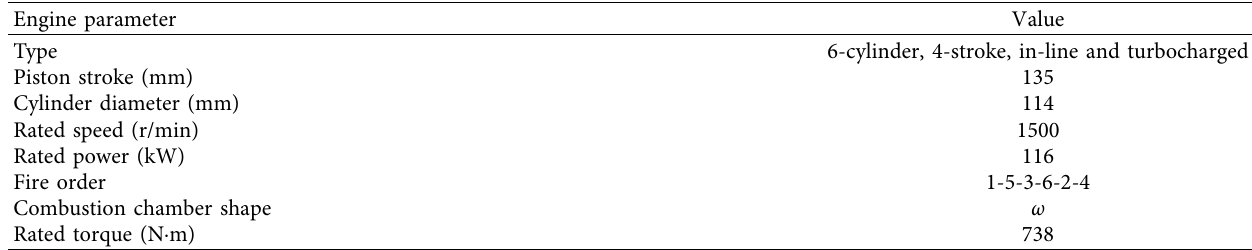
Table 1: Main parameters of the diesel engine.